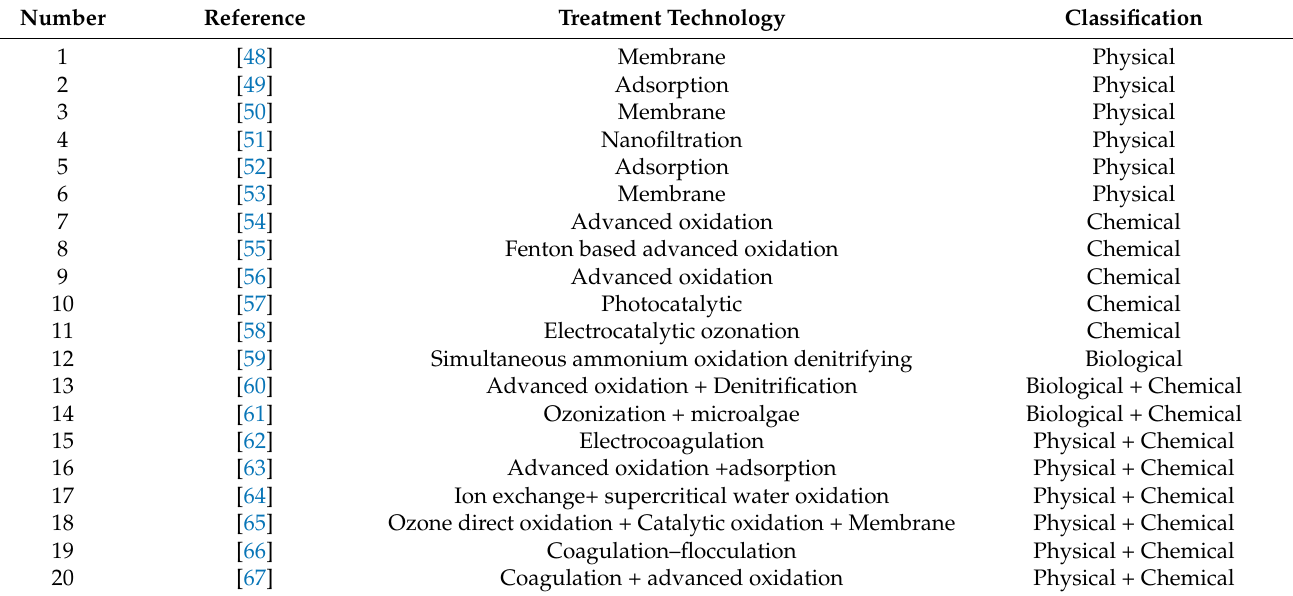
Table 7. Treatment technologies of landfill leachate in the years